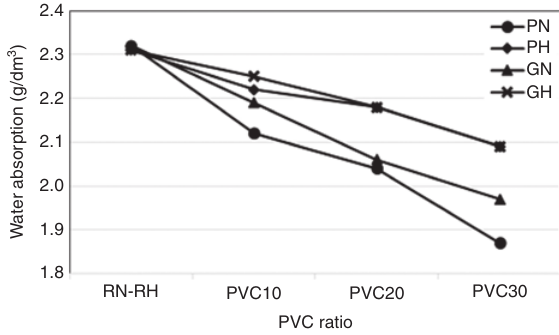
Figure 9 Water absorption tests of polyvinyl chloride-containing concretes.